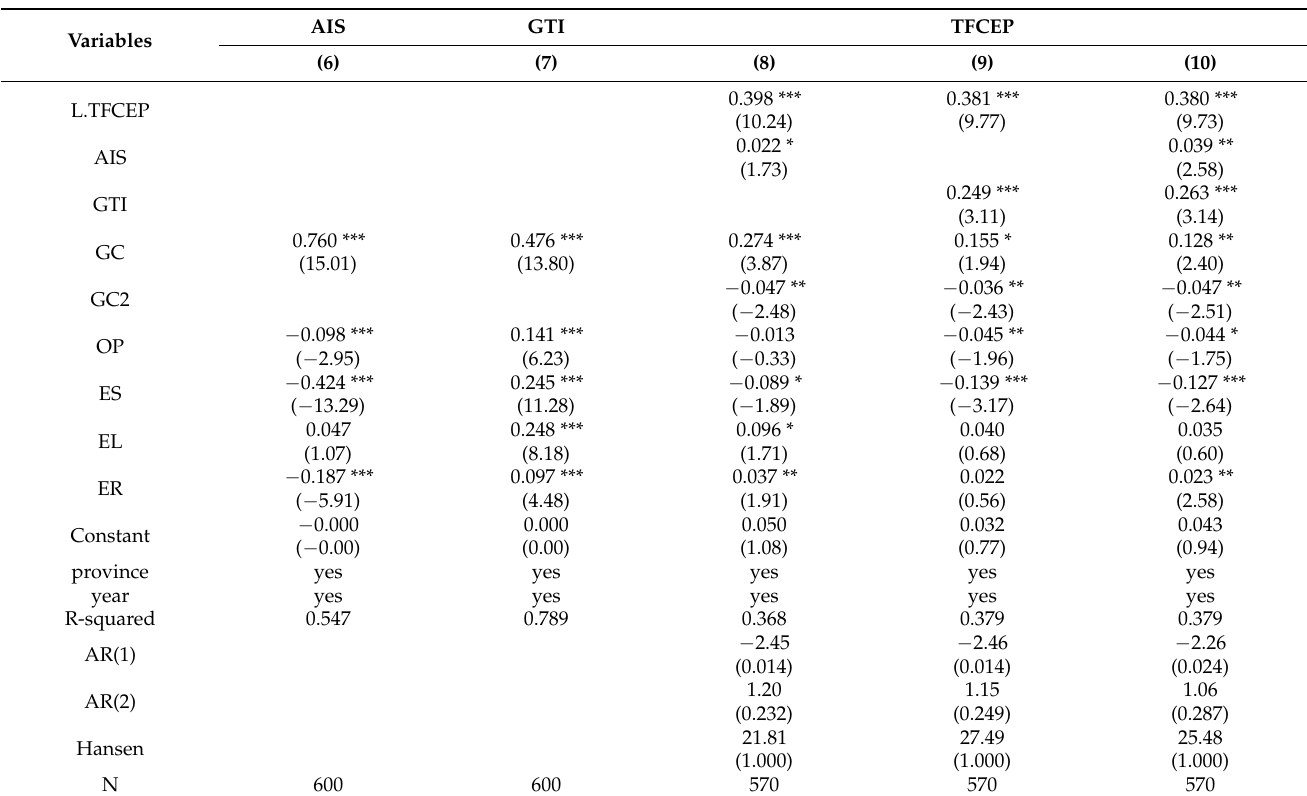
Table 3. Regression analysis of mediation